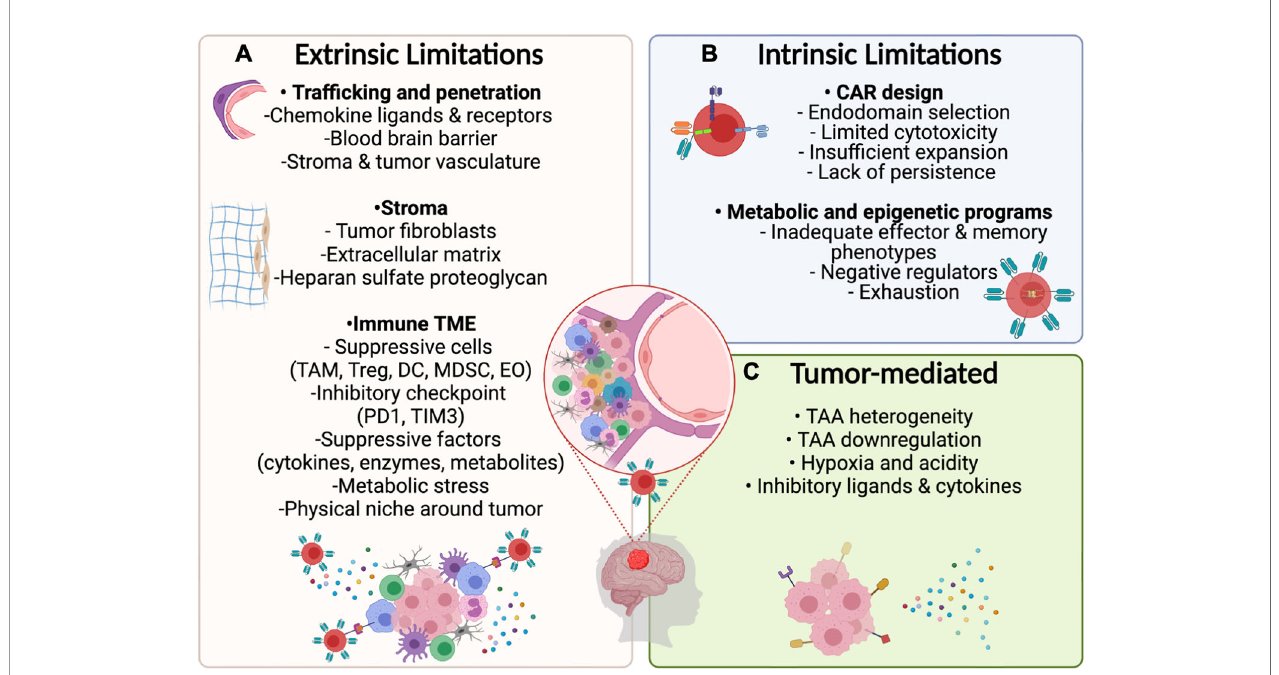
FIGURE 2 | Potential limitations for CAR T – cell therapy in PBTs. (A) Extrinsic Challenges for CAR T – cell immunotherapy will depend on the ability of designed products to home to the tumor by overcoming the physical limitations induced by the BBB and stroma surrounding the tumor followed by surviving the suppressive immune TME including inhibitory cytokines and ligands. (B) Intrinsic limitations depend on optimizing the CAR design and programs that control metabolic and epigenetic functions to mediate necessary cytotoxic mechanisms while preventing exhaustion. (C) Tumor cells may resist CAR T cell therapies by downregulating targeted antigens and by exerting environmental stress on CAR T – cells through the release of suppressive cytokines and expression of inhibitory